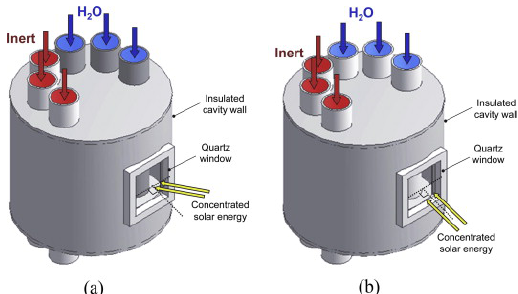
Figure 8. Schematics of the SurroundSun reactor receiver for ( a ) temperature swing and ( b ) isothermal operation. Reprinted from [111] with permission from